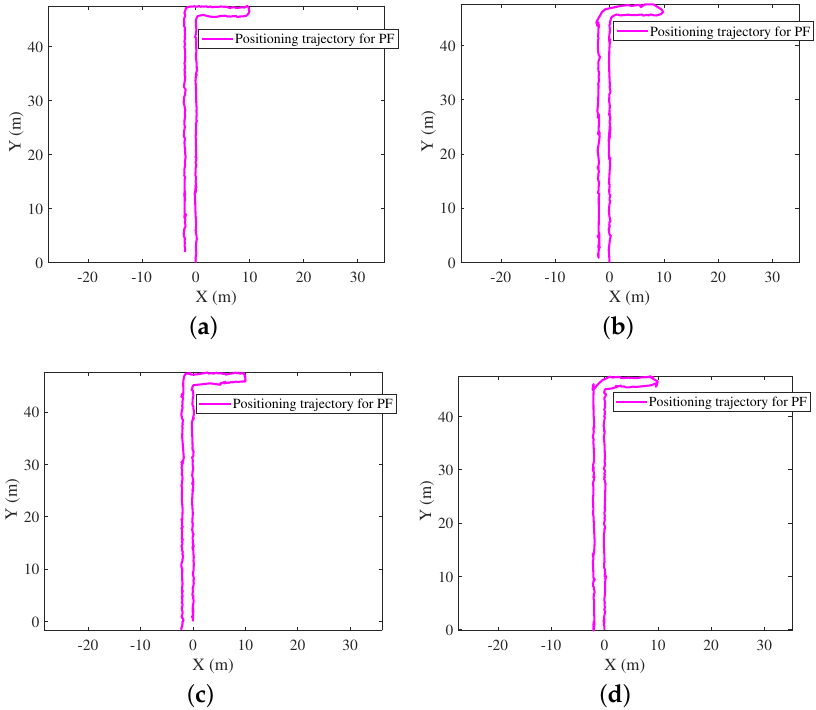
Figure 10. Navigation trajectories for PF. ( a ) Calling mode. ( b ) Dangling mode. ( c ) Handheld mode. ( d ) pocketed